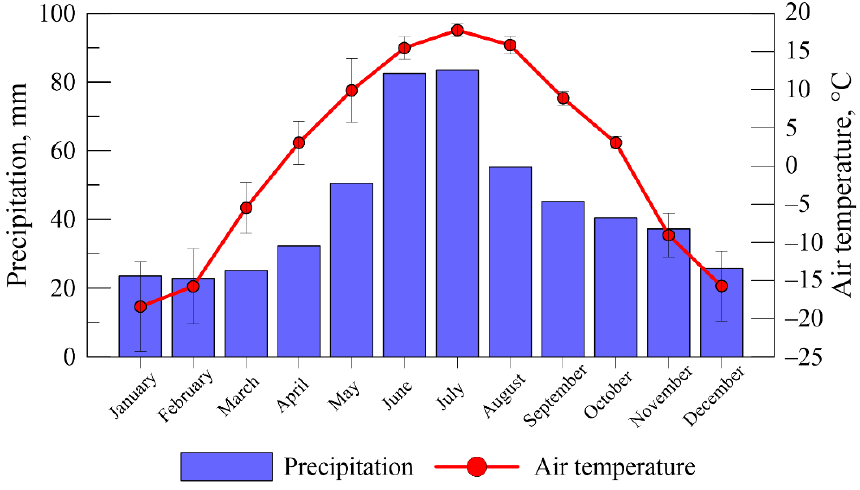
Figure 2. Weather conditions: average monthly air temperature and precipitation, average for 2019 – 2021.